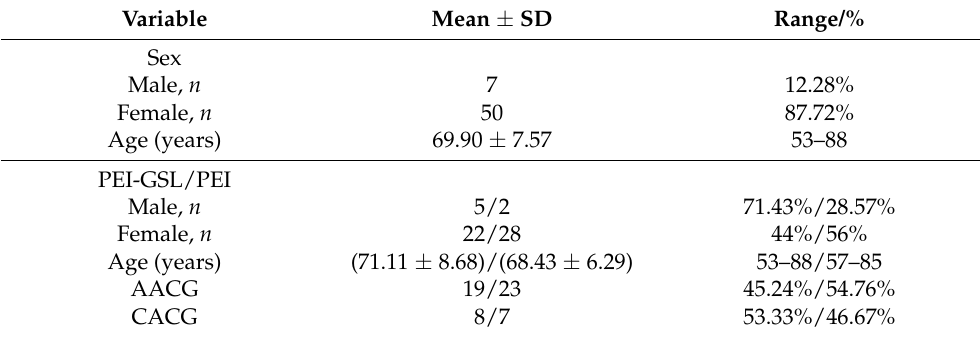
Table 1. Basic characteristics of